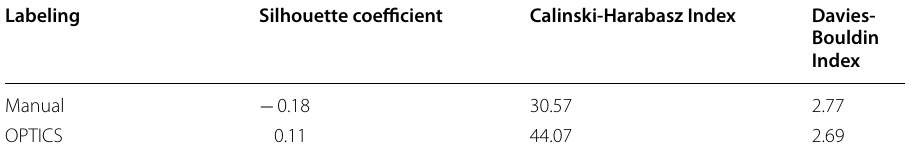
Table 3 Comparison of labeling using clustering metrics